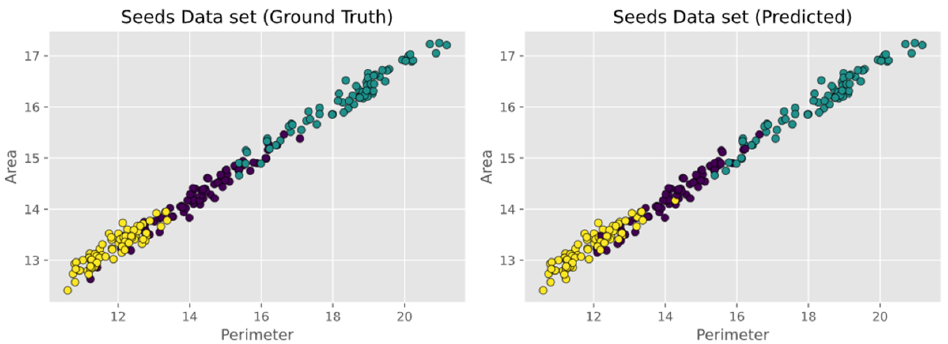
Figure 19. Ground truth vs. predicted labels from FNN-PSO algorithm on Sonar Figure 20. Accuracy of the algorithms on the Iris data set. 84.35% 99.16%